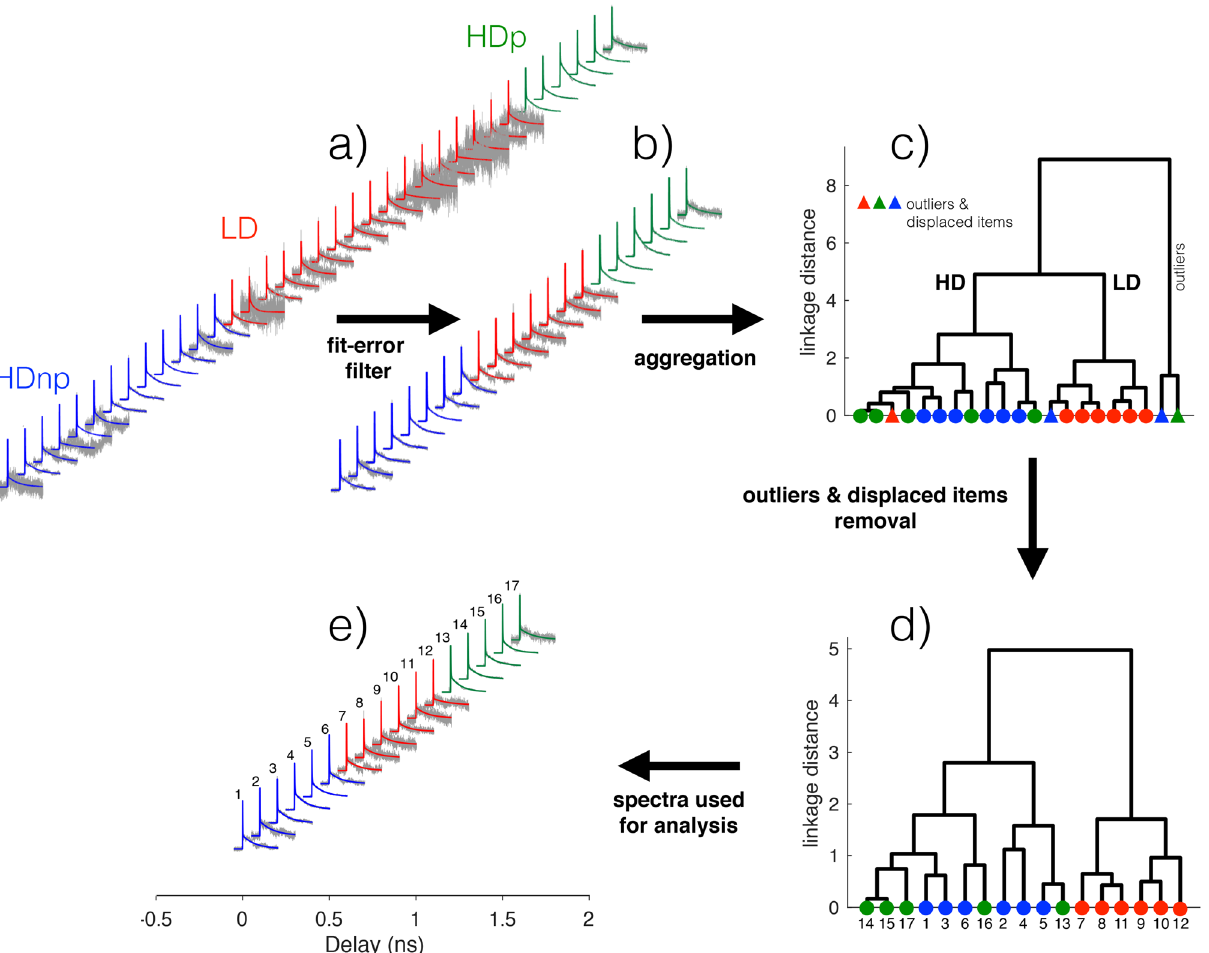
Figure 2. The set of measurements (gray lines, displaced for clarity) and the superposed fit functions (colored continuous lines) are shown in ( a ). The color code is as follows: blue, high density without plasma treatment (HDnp); red, low density (LD); green, high density with plasma treatment (HDp). In ( b ) are shown the filtered spectra using the fitting error as a parameter (see text for details). The results of the hierarchical clustering algorithm based on Ward’s method are shown as a dendrogram in ( c ). The leaves (that constitute the lower terminal part of the dendrogram) represent the spectra as seen in ( b ), ordered hierarchically. The same color code as in ( a ) is used. The dendrogram, pruned away from outliers and displaced items, is shown in ( d ). The remaining spectra, used for subsequent analysis, are shown in ( e